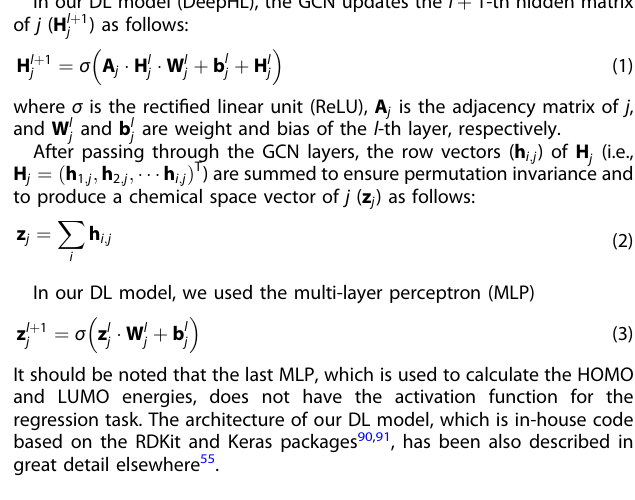
Algorithm of our deep learning model